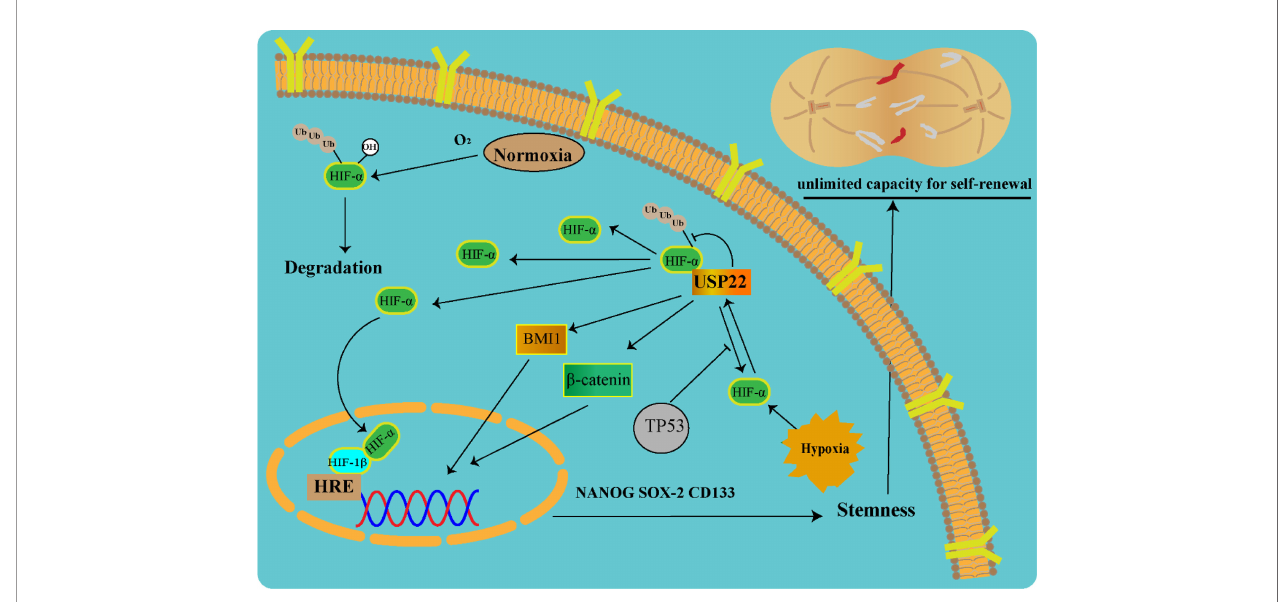
FIGURE 3 | USP22-mediated tumor stemness in a hypoxic microenvironment (USP22 upregulates stemness gene expression via Wnt/ b -catenin, HIF-1 a , and BMI1